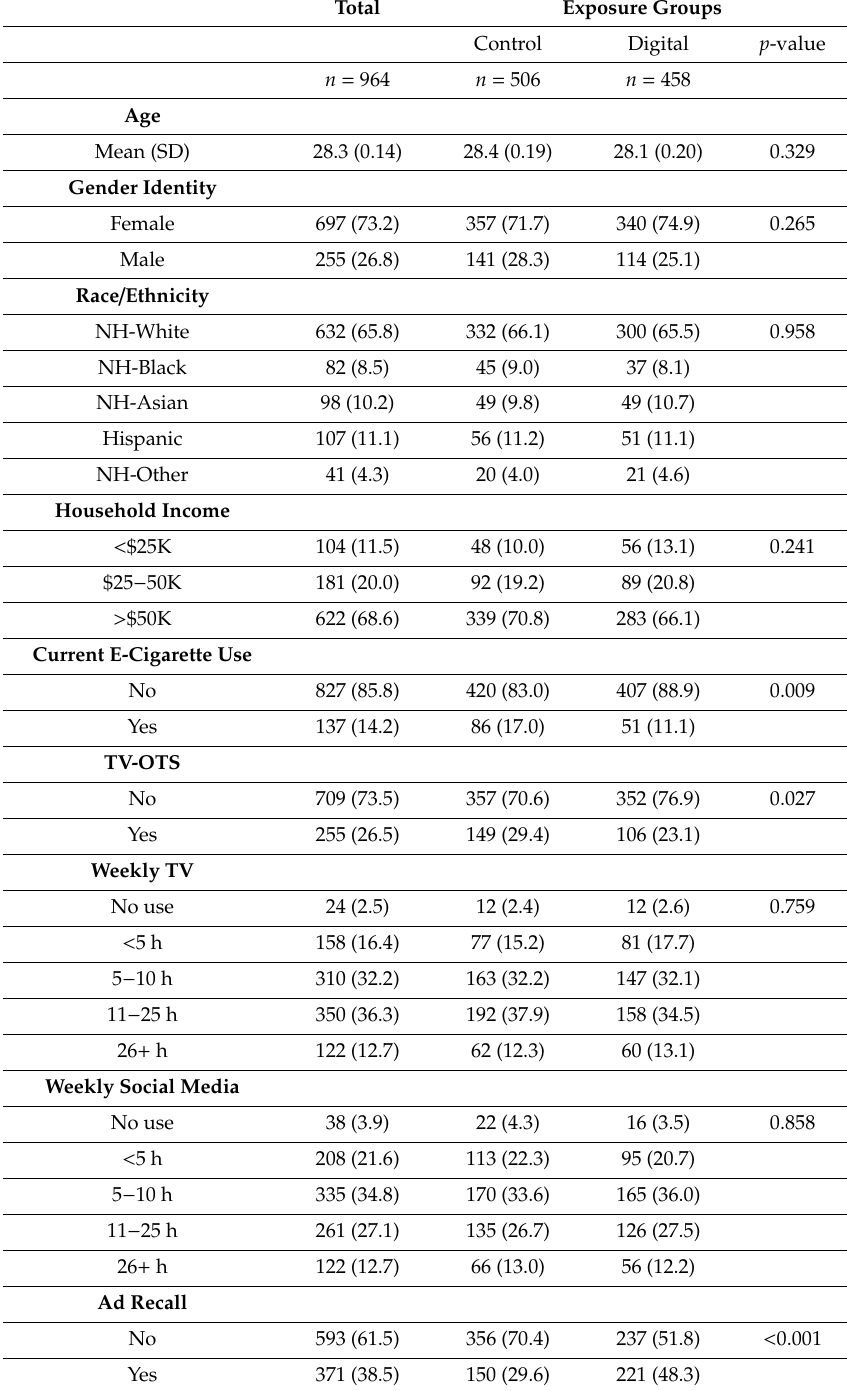
Table 1. Sample characteristics, frequencies (column percentages), or means